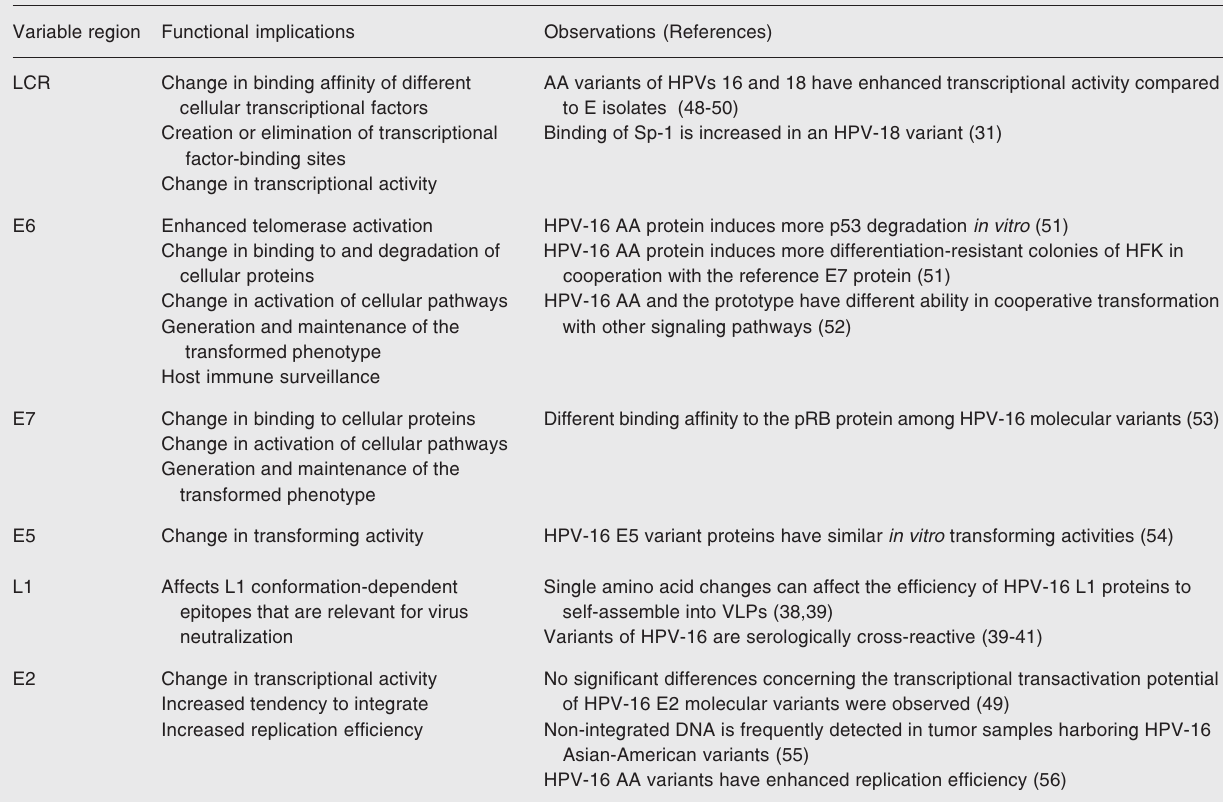
Table 2. Functional implications of human papillomavirus (HPV) gene variability. Variable region Functional